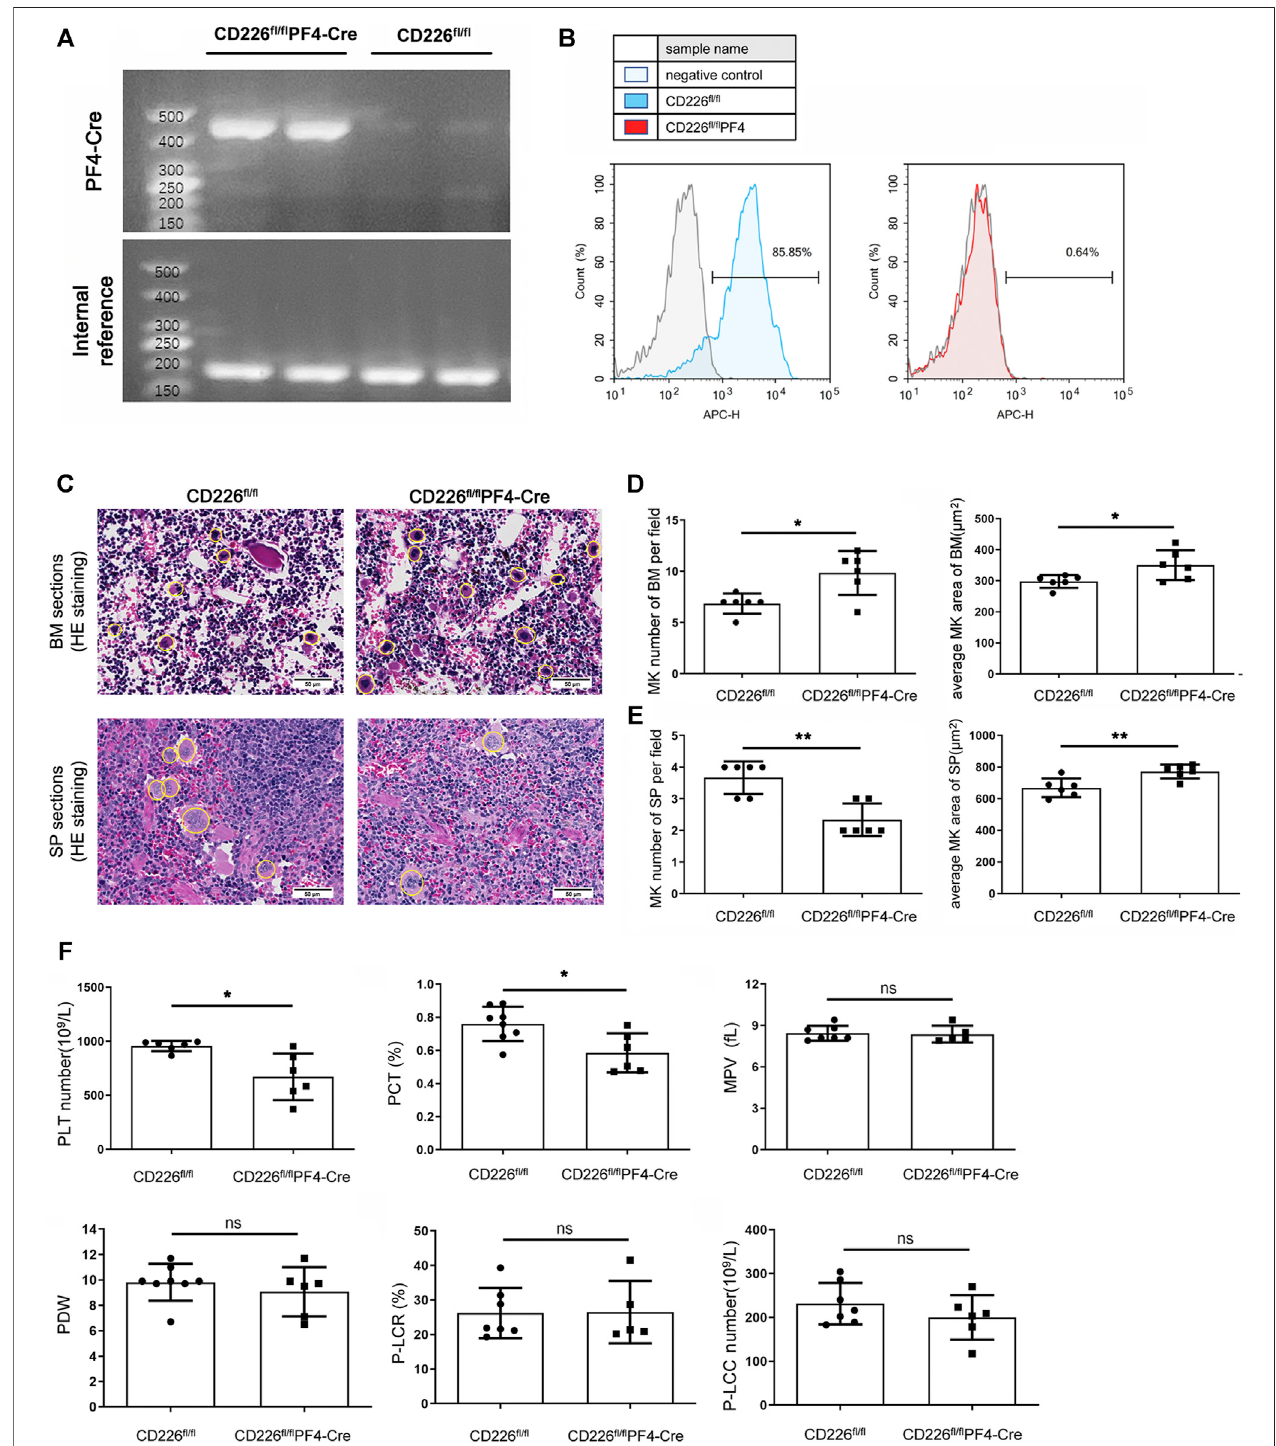
FIGURE 1 | Deletion of platelet CD226 disturbed the homeostasis of MKs/platelets. (A) Identi fi cation of CD226 fl / fl and CD226 fl / fl PF4-Cre mice through PCR of DNAs extracted from the tail. (B) Flow cytometry images showing CD226 expression in CD226 fl / fl and CD226 fl / fl PF4-Cre mice. (C) HE staining of BM and spleen sections. The MKs are circled; scale bar (cid:1) 50 µm. (D, E) MK number and average MK area in BM and spleen sections. (F) Routine blood test results of platelets (PLT) number, plateletcrit (PCT), mean platelet volume (MPV), platelet distribution width (PDW), platelet-large cell ratio (P-LCR), and platelet-large cell count (P-LCC). Statistical signi fi cance between groups was analyzed using independent-sample t -tests with two-tailed p value. * p < 0.05, ** p < 0.01, ns (cid:1) no statistical signi fi cance.